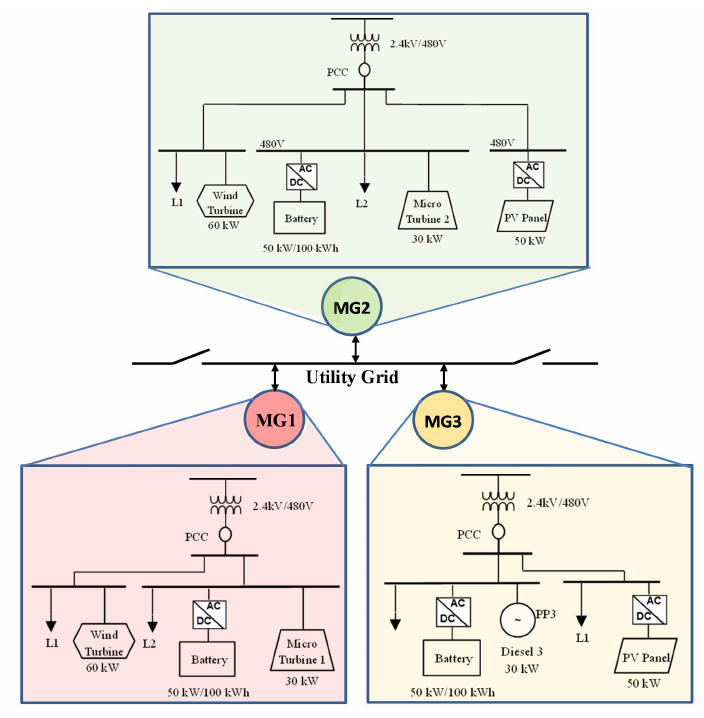
Figure 3. Modified ORNL DECC networked microgrids test